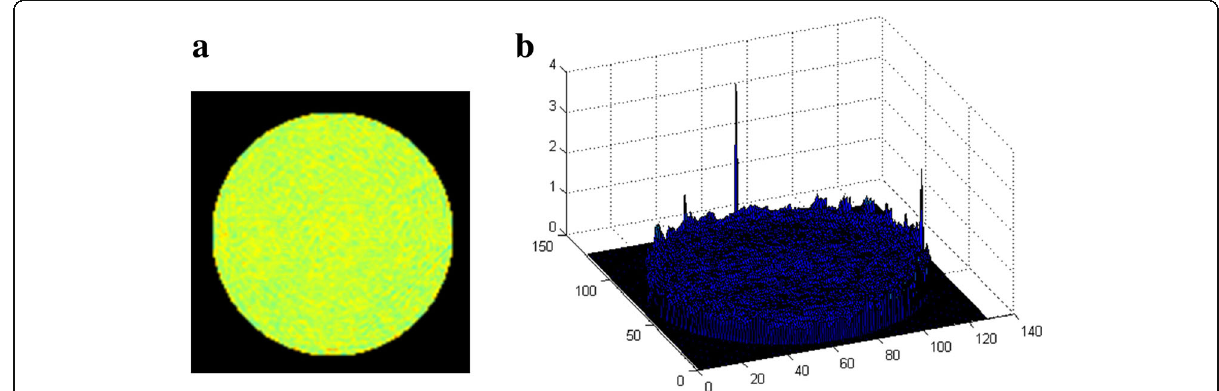
Fig. 3 Healthy object reconstruction image and slowness: a reconstruction image of healthy object, b healthy object